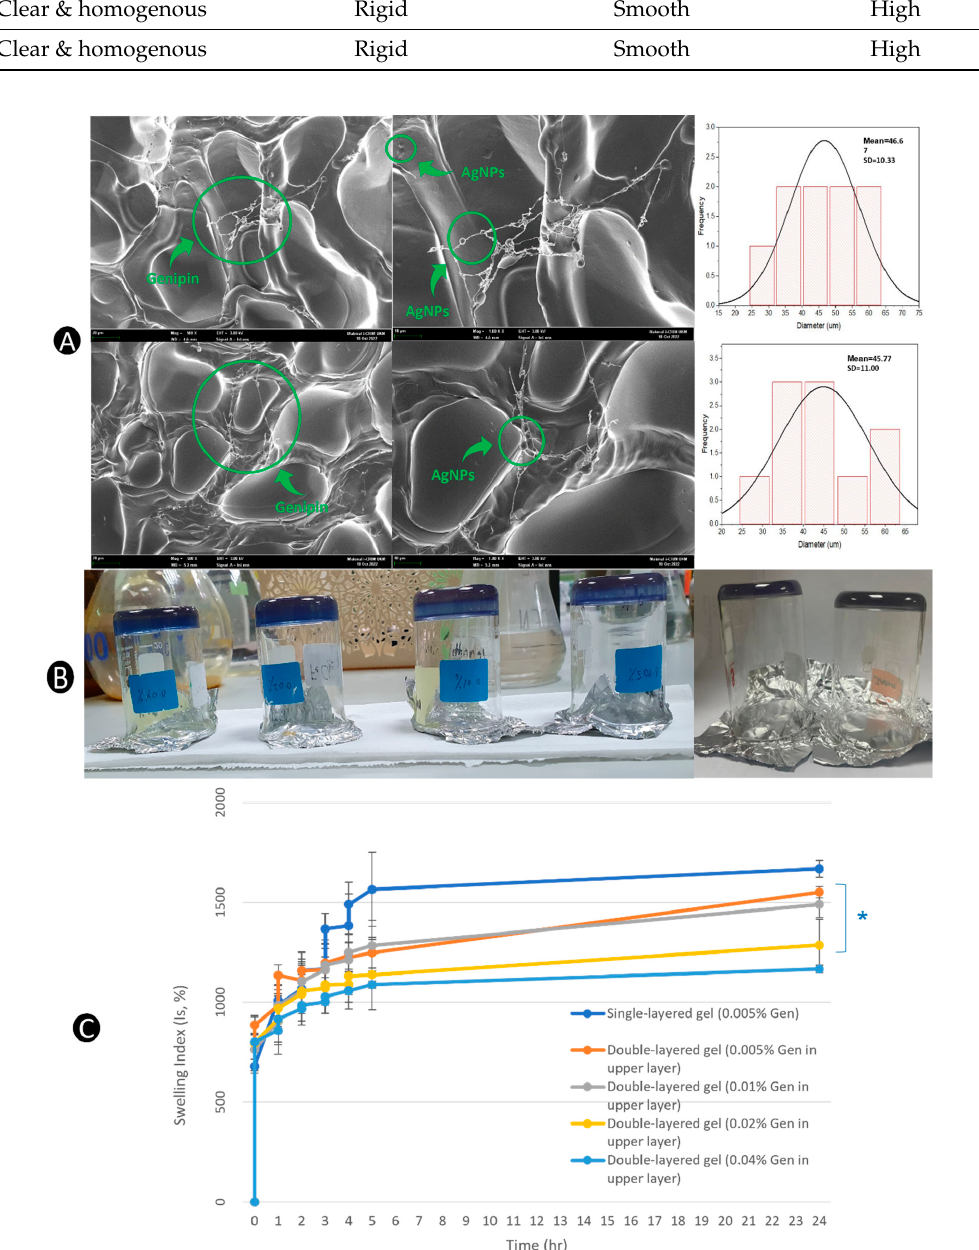
Figure 6. ( A ) SEM micrographs of the upper layer ( top ) and lower layer ( bottom ) of hydrogel with genipin (0.005% w / v ) containing AgLTF at 0.5 kx ( left ) and 1.0 kx ( right ), ( B ) Adhesion test of DL hydrogel samples containing various concentrations of genipin (0.005%, 0.01%, 0.02%, and 0.04%) and SL hydrogel (genipin 0.005%), and ( C ) Swelling index over time graph of hydrogel samples, n = 3. * statistically non-significant difference from the single-layered gel (0.005% genipin) ( p > 0.05).